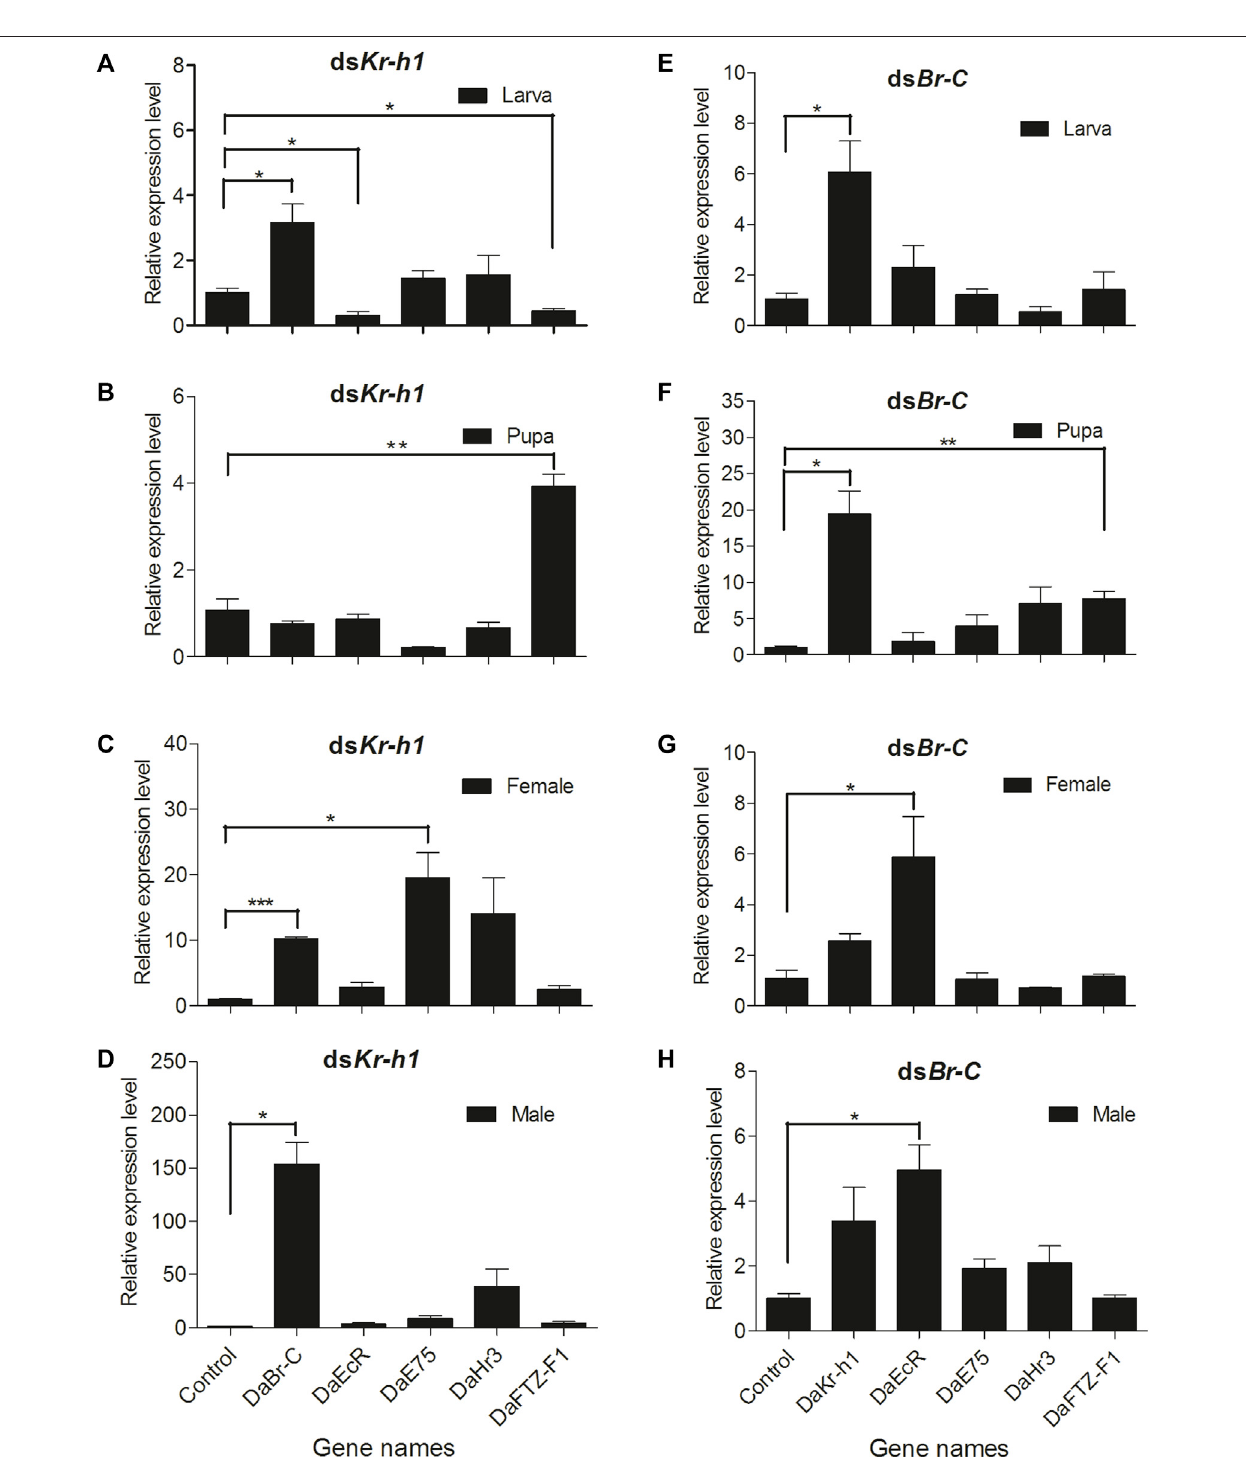
FIGURE 8 | DaKr-h1 and DaBr-C knockdown affects JH signaling pathway-related genes. The larvae, pupae, and emerged adults were allowed to ingest with L4440 (negative control), ds Kr-h1 , and ds Br-C for 3 days. DaKr-h1 , DaBr-C , DaEcR , DaE75 , DaHr3 , and DaFTZ-F1 transcript levels were measured. DaKr-h1 knockdown in larvae (A) , pupae (B) , adult females (C) , and adult males (D) . DaBr-C knockdown in larvae (E) , pupae (F) , adult females (G) , and adult males (H) . The columns represent means with vertical lines indicating the standard error. Asterisks denote signi fi cant differences (unpaired t -test; * p < 0.05, ** p ≤ 0.01, *** p ≤